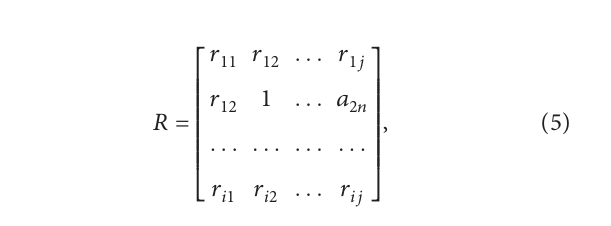
Figure 3: The cloud models of assessment indicators of the risk level for the existing